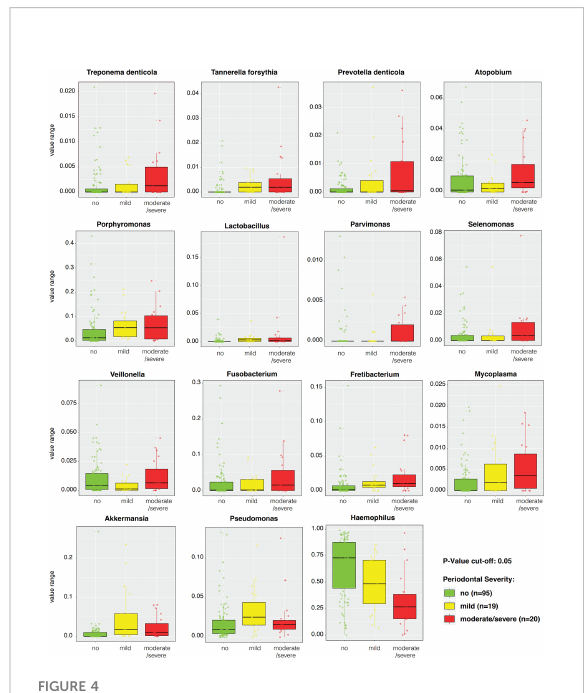
FIGURE 4 Linear discriminant analysis Effect Size (LEfSe) boxplots of signi fi cantly distinctive genera and species according to periodontal severity with a p-value cut-off <